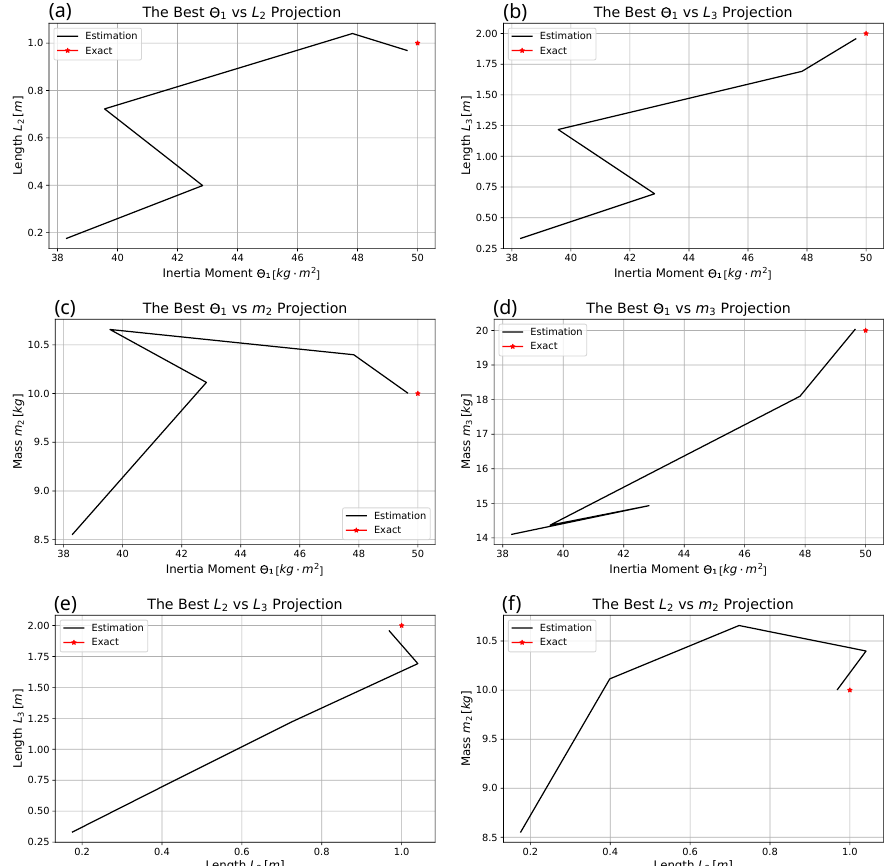
Figure 9. Projection of the estimated elements ( a ) Θ 1 vs. L 2 ( b ) Θ 1 vs. L 3 ( c ) Θ 1 vs. m 2 ( d ) Θ 1 vs. m 3 ( e ) L 2 vs. L 3 ( f ) L 2 vs. m 2 .